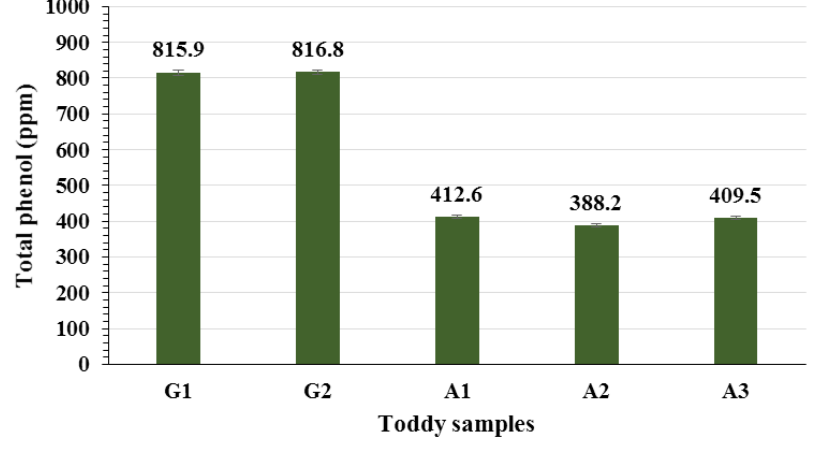
Figure 3: T otal phenol content in toddy samples.